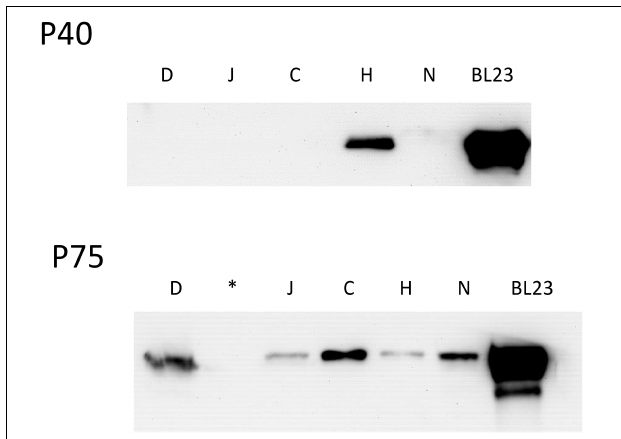
FIGURE 7 | Western blot of the supernatant of different commercial dairy products containing Lactobacillus casei (D, J, C, H, N). Product names have been replaced by letter codes to avoid conflict of interests. In position 6 BL23 supernatant was included as a reference. ( ∗ ) In the image of P75 blot, the second line was not loaded with